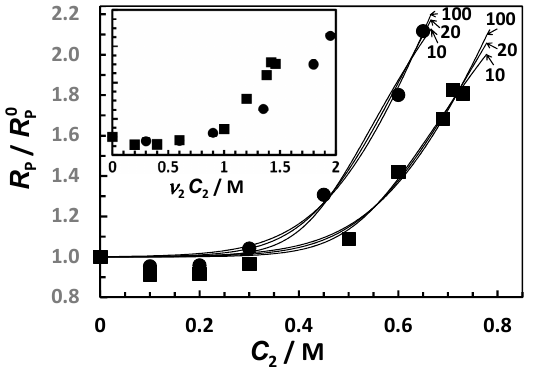
Figure 4. Normalized Stokes’ radius, R P / R P0 , as a function of salt concentration, C 2 , with R P0 being R P at C 2 = 0 (Na 2 SO 4 , ● ; MgSO 4 , ■ ). Curves are fits through the data based on Equations (12) and (14), as discussed in the text below. Employed values of a (see Equation (11) for definition) are appended to each curve. Inset shows the same data plotted as a function of salt osmolarity, ν 2 C 2 .